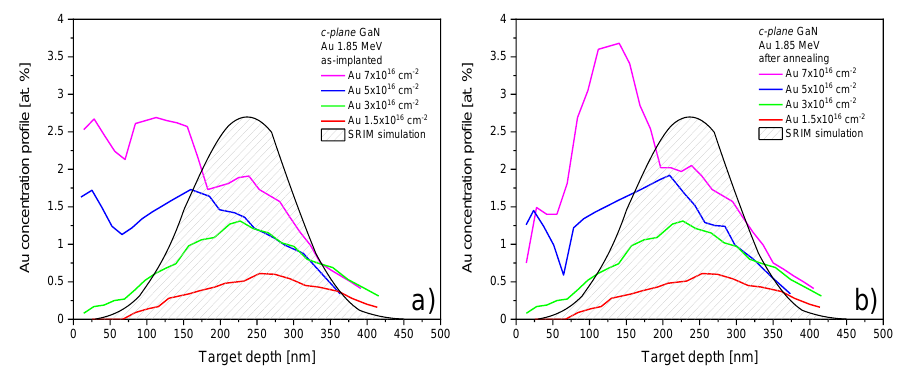
Fig. 2. – The comparison of SRIM calculated Au-depth distribution corresponding to the fluence 5×10 16 cm -2 of 1.85 MeV Au ions with the experimentally determined Au-concentration depth profiles in a) and after the subsequent annealing in